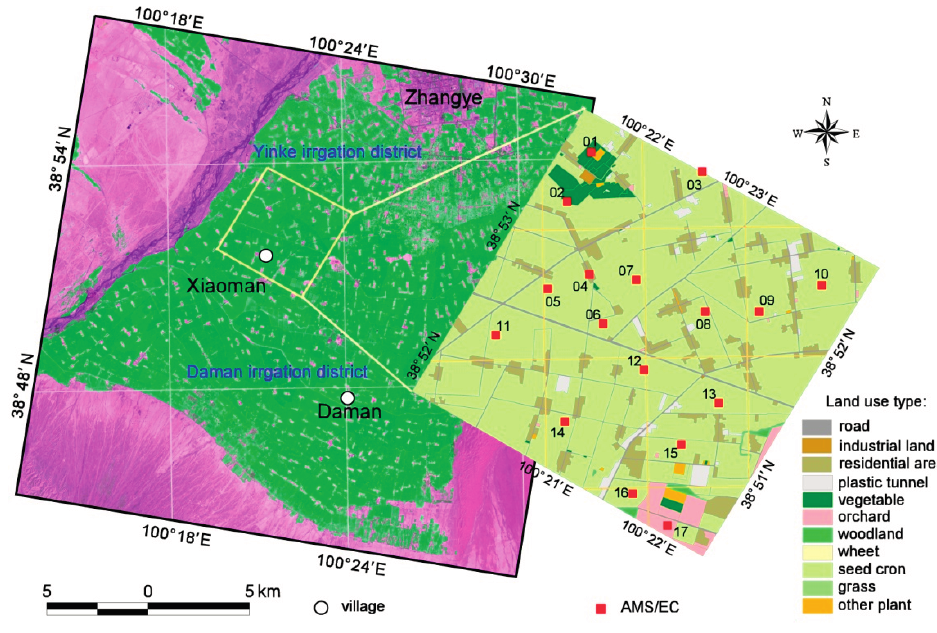
Figure 1. Land cover and the meteorological instrumentation configuration in the study